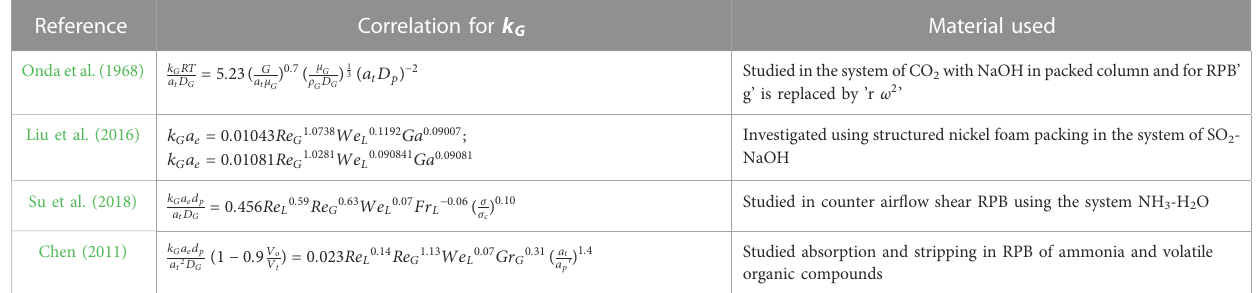
TABLE 4 Gas phase mass transfer coef fi cient correlation in RPB. Reference Correlation for k G Material